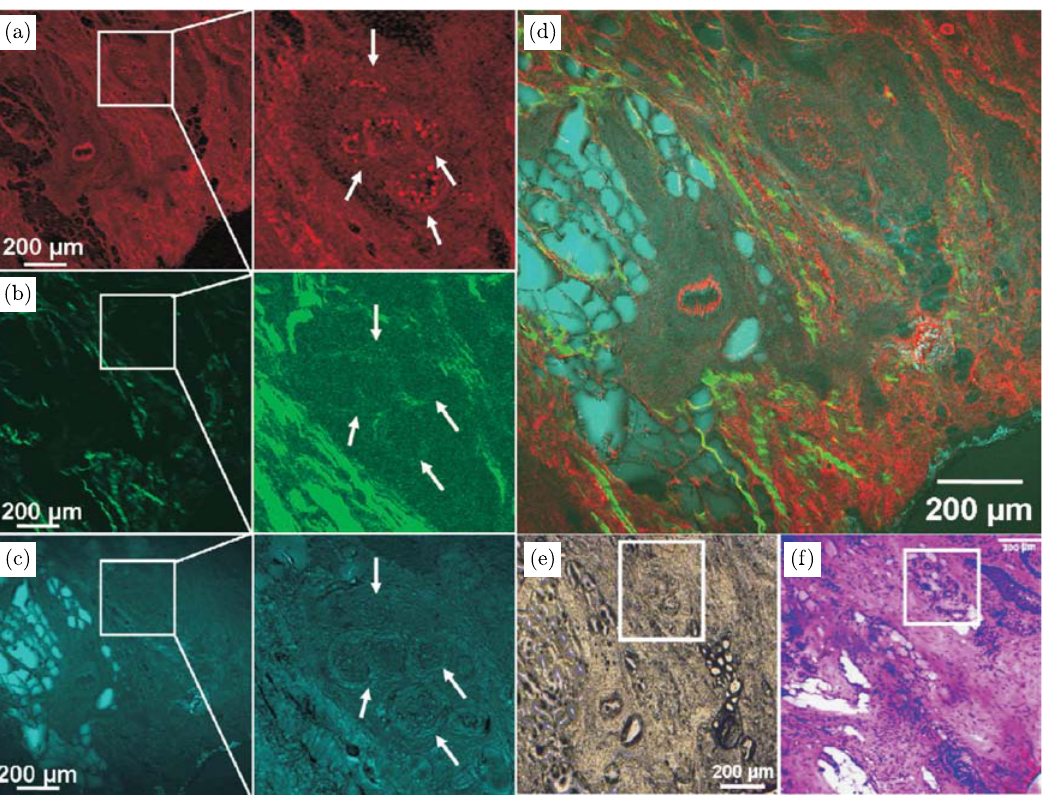
Fig. 3. Multimodal TPF-SHG-CARS imaging. (a) TPF images (coded in red) highlighting dominantly °uorescing proteins and cofactors. (b) SHG images (coded in green) showing collagen distribution. (c) Fat reservoirs as well as membranes visualized with CARS microscopy (coded in cyan). In all three images the tumor can be found (indicated by the arrows). (d) Multimodal image of BCC obtained by merging individual images. (e) Bright ¯eld image with the tumor area indicated by the white box. (f) Histological H&E stained image for comparison. The tumor area is indicated by the white box. Figure modi¯ed from Ref.